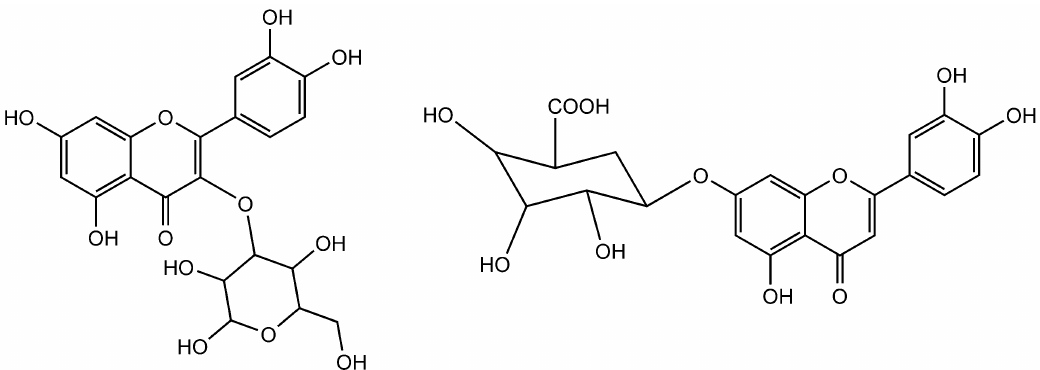
Figure 7. Quercetin-3- O -glucoside (Left side) and luteolin-7- O -β- D -glucuronide (Right side).